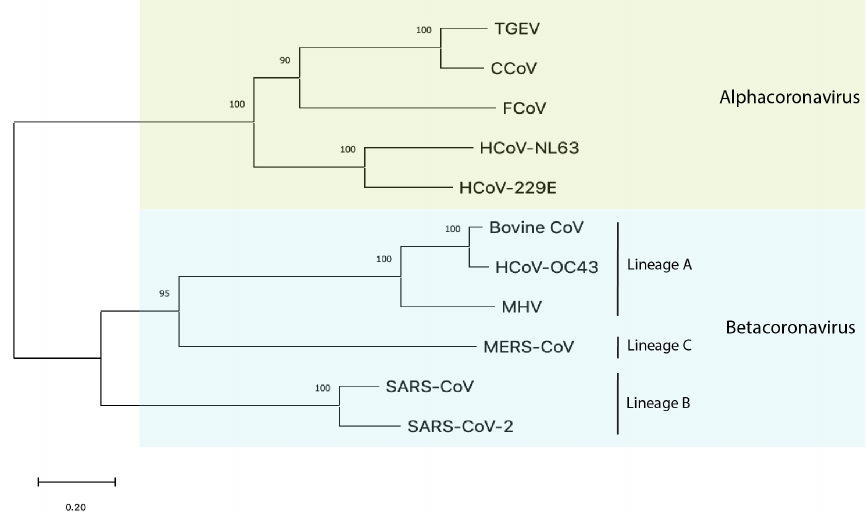
Figure 1. Phylogenetic tree of the spike proteins of selected coronaviruses. A maximum likelihood phylogenetic tree was constructed using MEGAX (100 bootstraps) from a multiple sequence alignment of spike protein sequences. Spike amino acid sequences were obtained from NCBI GenBank.